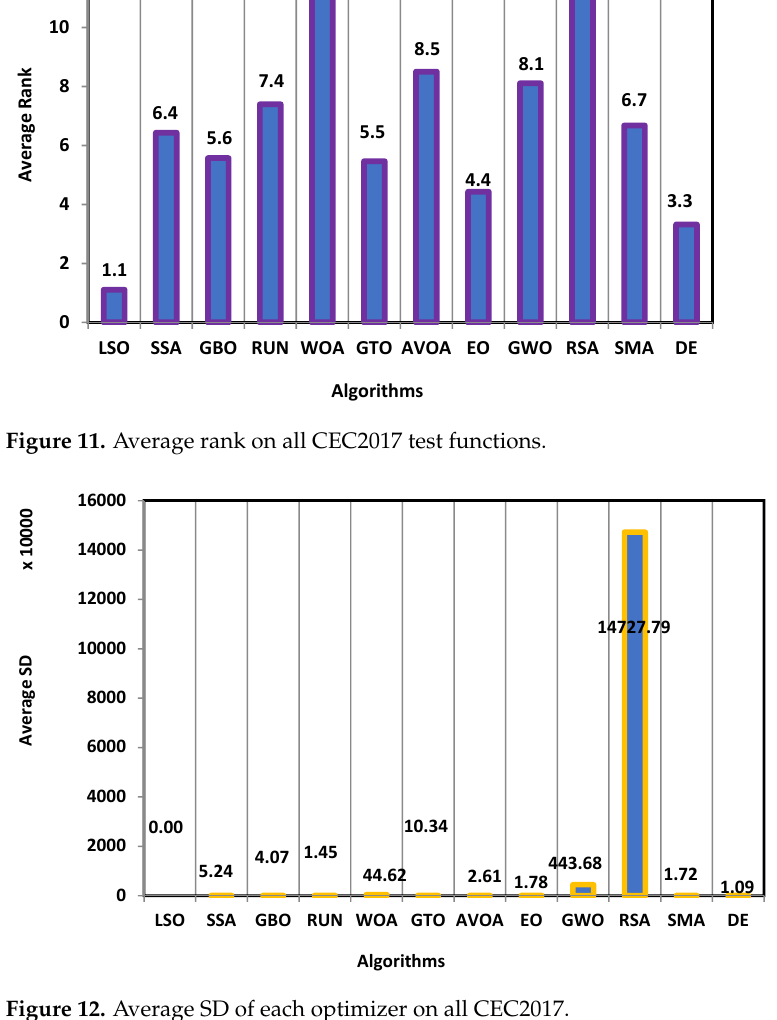
Table 11. p -values of LSO with each rival optimizer on CEC-2017 test suite (F51–F79).